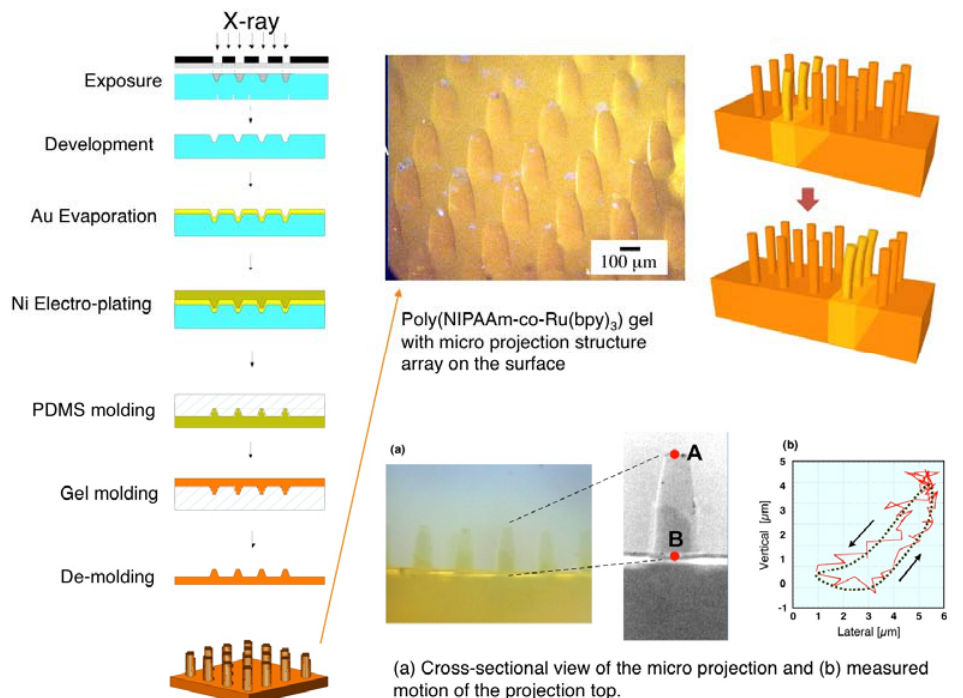
Figure 6. Fabrication of ciliary motion actuator (artificial cilia) using self-oscillating gel (Reference